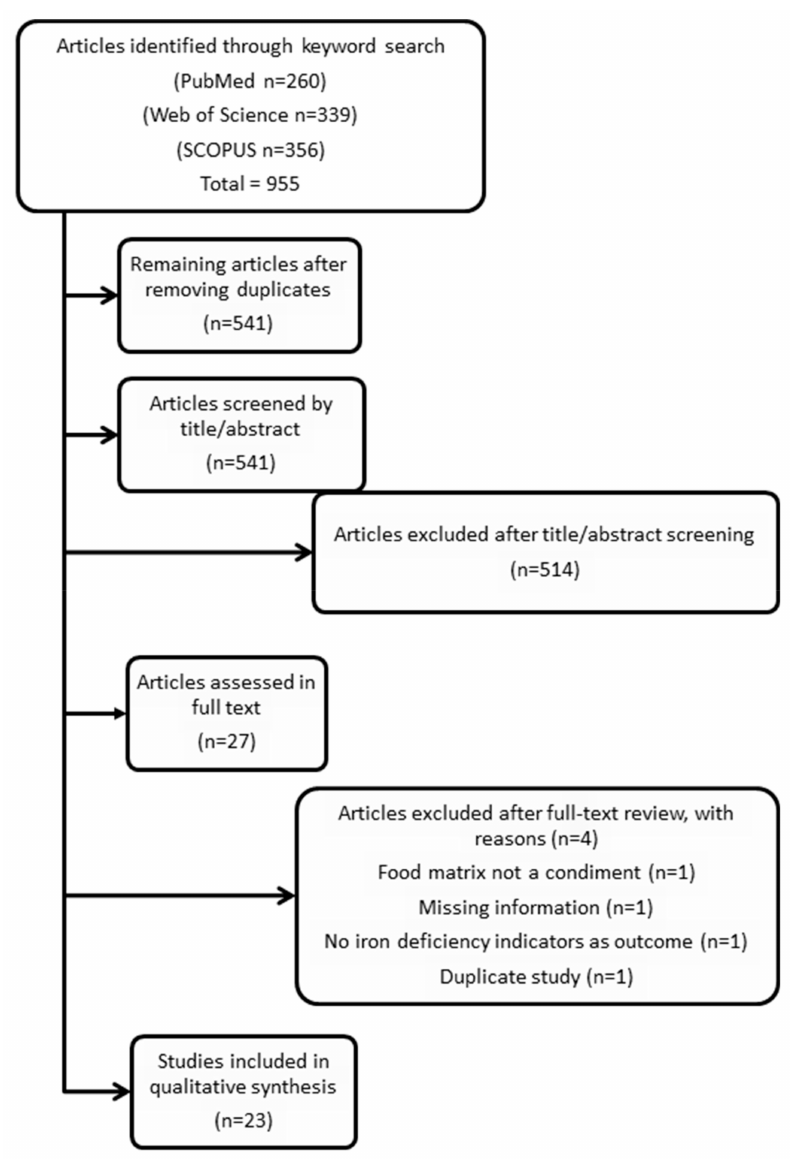
Figure 1. PRISMA study selection flow